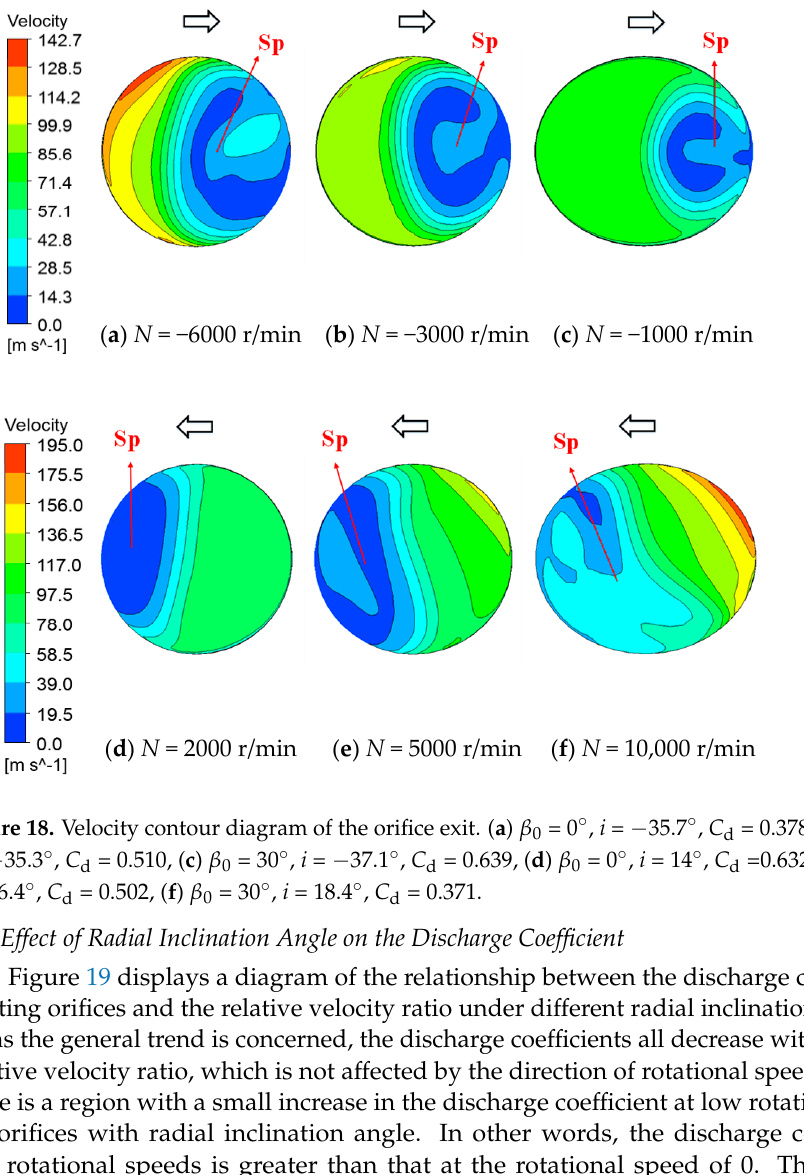
= 0.639, ( d ) 𝛽 (cid:2868) = 0°, i = 14°, 𝐶 d = 0.371. d